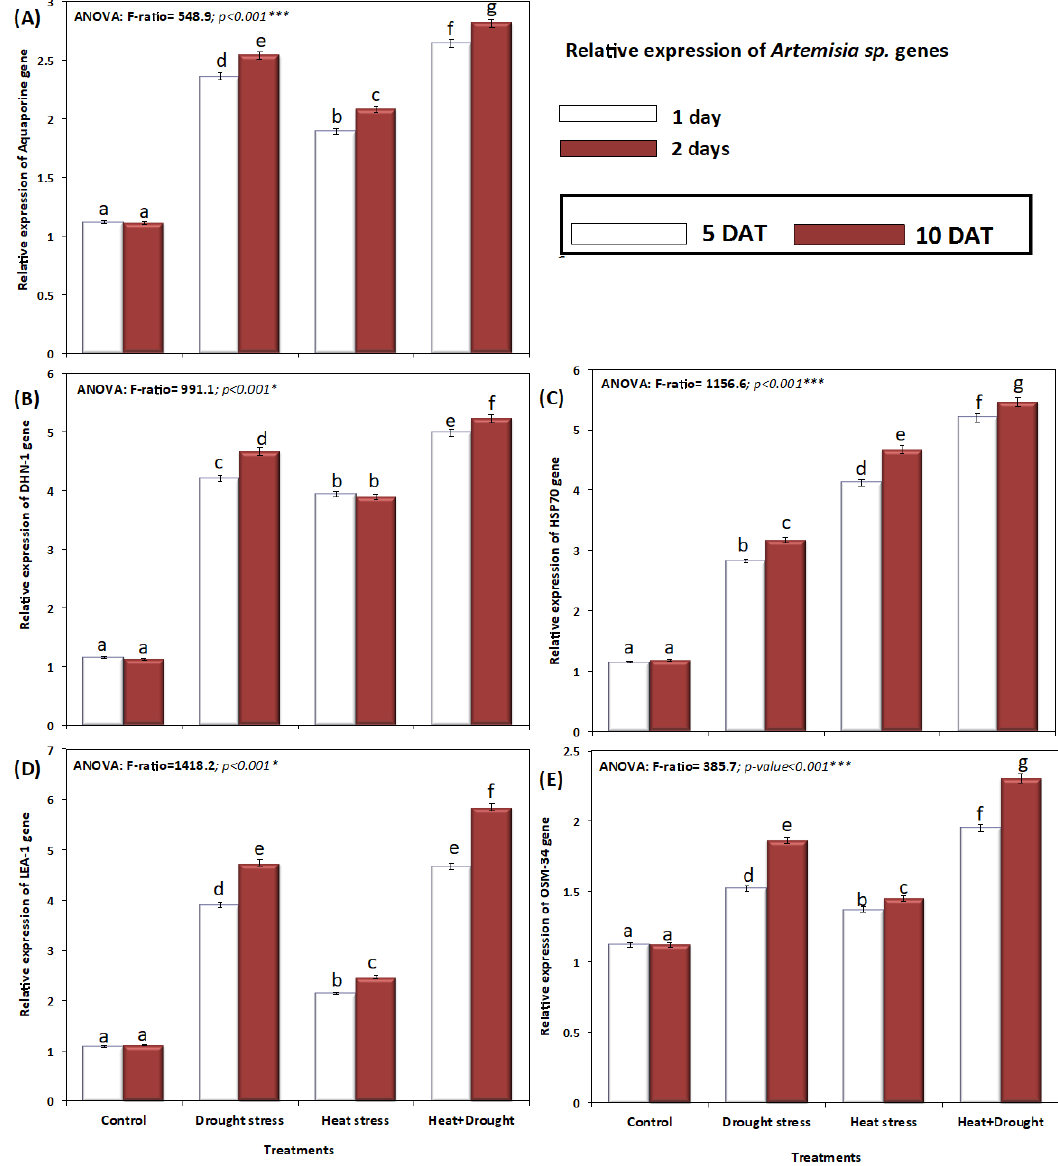
Figure 11. Relative gene expression of A. sieberi alba. Under the effect of drought, heat, and interaction between drought and heat stresses on ( A ) aquaporin gene, ( B ) DHN-1 gene, ( C ) HSP-70 gene, ( D ) LEA-1 gene, and ( E ) OSM-34 genes. Data expressed as mean of triplicates, error bars represent standard error for means. Means marked with different letters are significantly different according to ANOVA and DMRTs at p < 0.05.